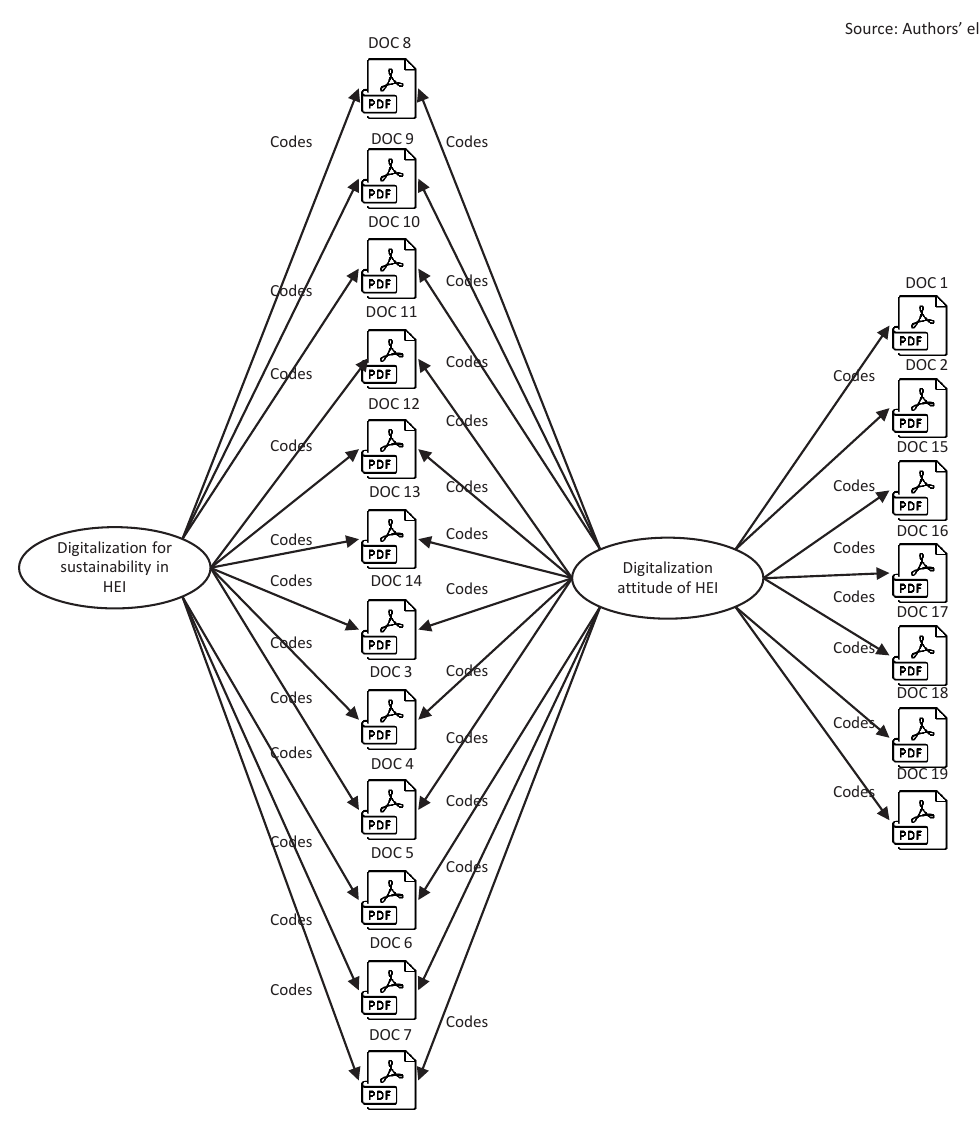
Figure 6. Commonalities between ATD and digitalization for sustainable development